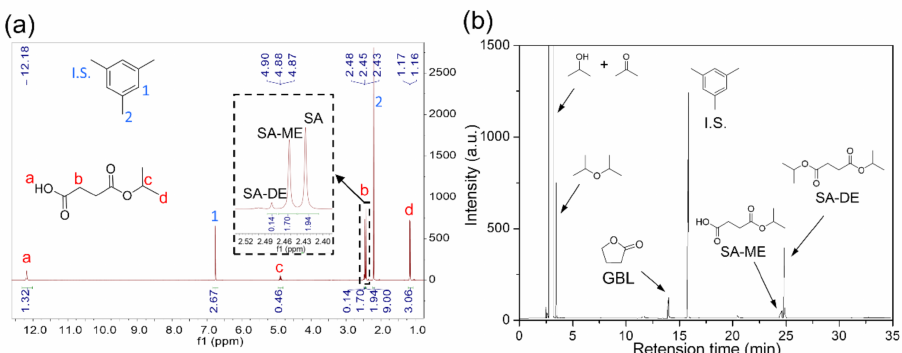
Figure 2. Product analysis: ( a ) NMR spectra of the reaction mixture of 190 ◦ C and 1 h in Figure 1a. ( b ) GC spectra of the reaction mixture of 250 ◦ C and 1 h in Figure 1a.